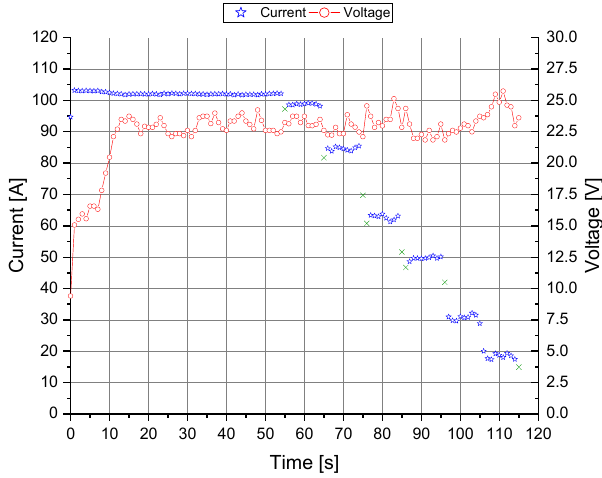
Figure 13. Measurement for the first series of trials in set 1. Pure argon 20 mm arc gap in the idle centered position.